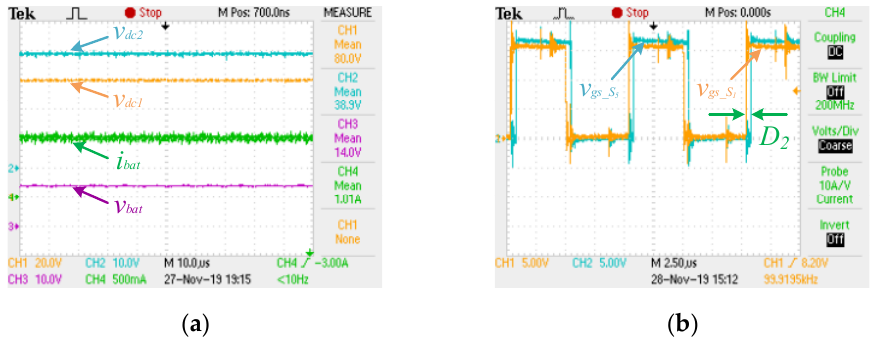
Figure 10. G2B operation mode: ( a ) voltage on the primary dc-link (CH1: 20 V/div), voltage on the secondary dc-link (CH2: 10 V/div), voltage on the BESS (CH3: 10 V/div), current at the BESS (CH4: 500 mA/div); ( b ) gate-source voltage waveform of the semiconductors S 1 (CH1: 5 V/div) and S 5 (CH2: 5 V/div) in an unbalanced situation.